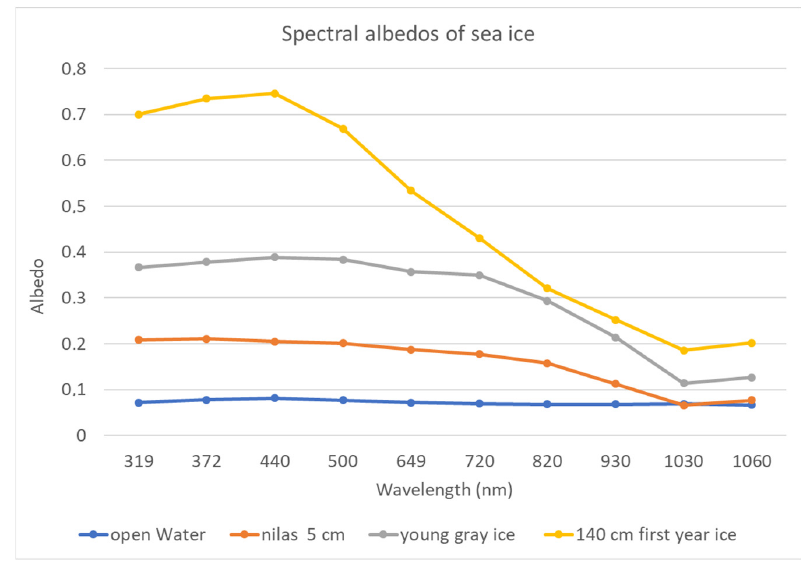
Figure 3. Spectral albedos of sea ice, after [17].